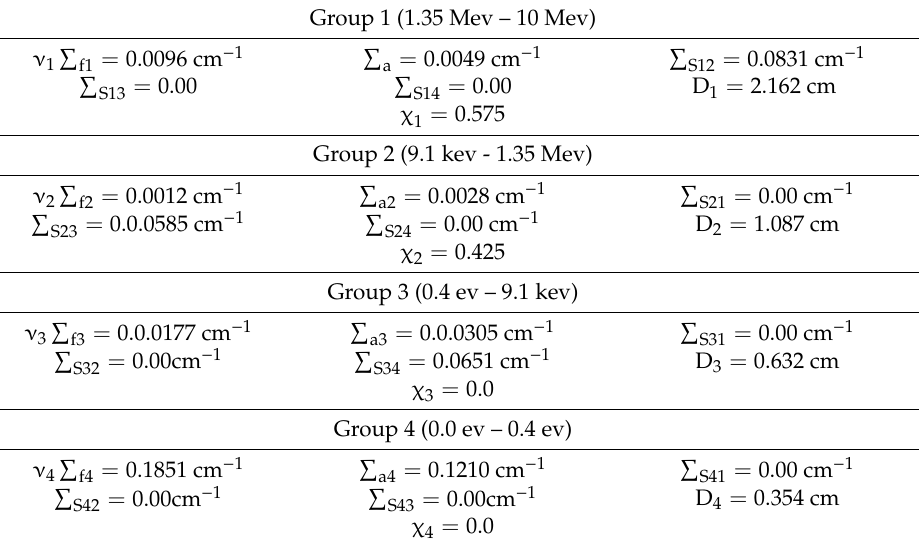
Table 9. Group data.